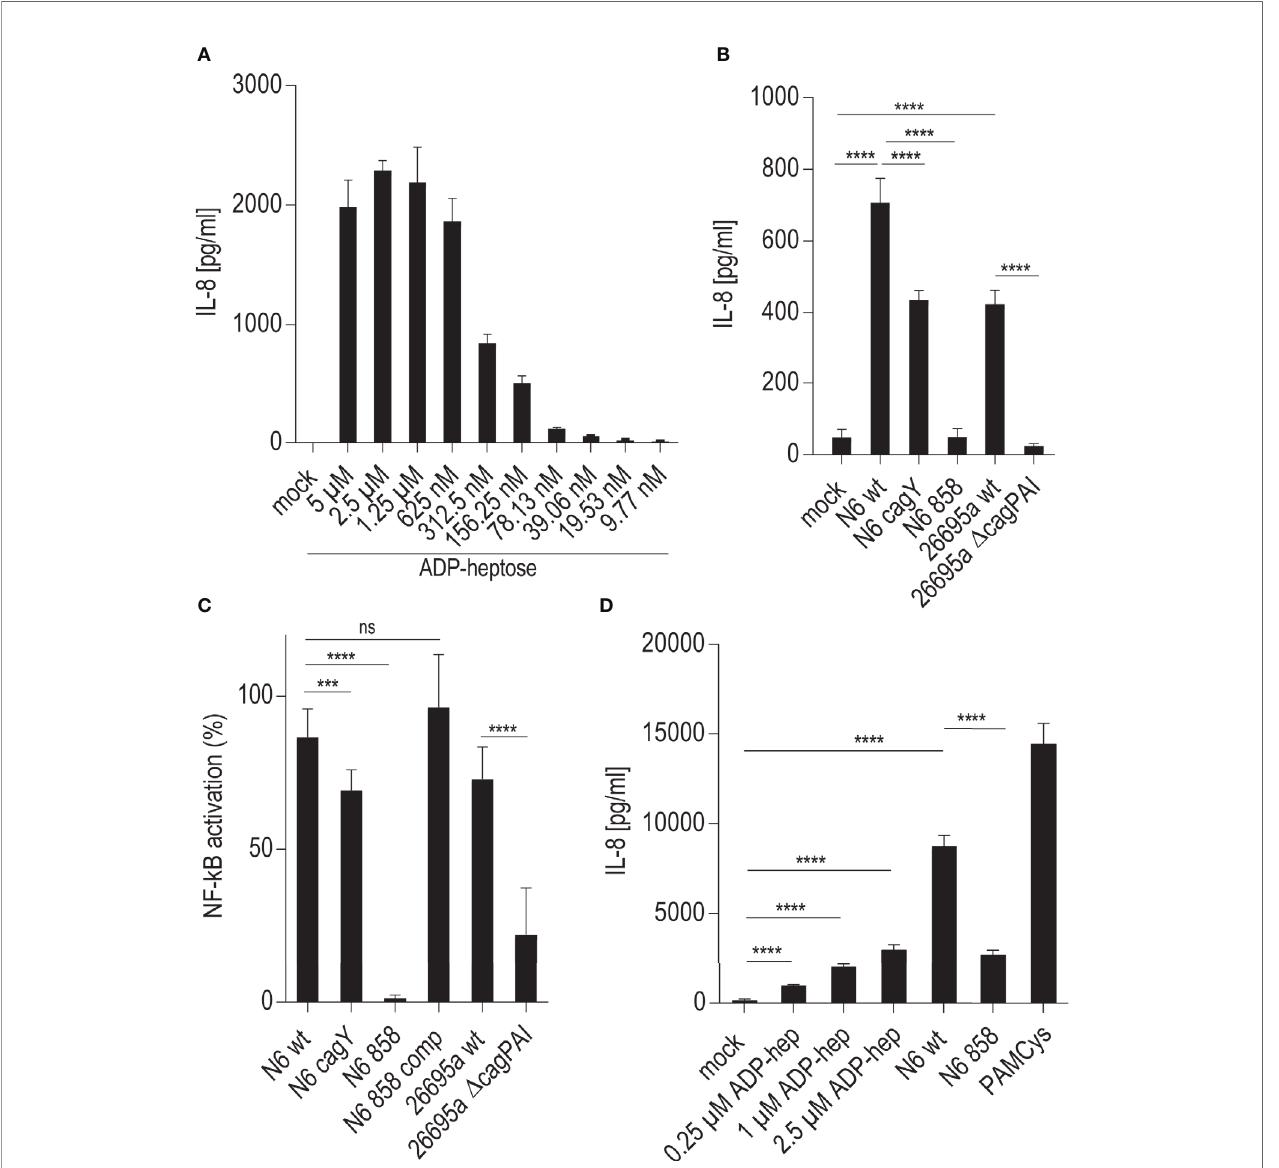
FIGURE 2 | Activation of monocyte/macrophage cell line Thp-1 and primary human macrophages by pure ADP-heptose, enzyme-treated bacterial lysates (ETL), and live H. pylori . (A) dose-dependent activation of Thp-1 cells by pure ADP-heptose: ADP-heptose in different concentrations as indicated was applied to Thp-1 monocyte/macrophages for 20 h in 24-well plates, and IL-8 secretion was quantitated using ELISA (for comparison, concentration-dependent activation of NF- k B reporter cells Thp1_luc by ADP-heptose is shown in Supplementary Figure S3A ). (B) Thp-1 cells were co-incubated with ETLs of two H. pylori strains and their isogenic cagY , D cag PAI, and hldE mutants for 20 h in 24-well plates (50 µl of lysates per well added to cells), followed by the quantitation of IL-8 secreted in the cell supernatant by ELISA. (C) ETLs prepared from two different H. pylori strains including their isogenic heptose mutant (N6 858) and complementant (N6 858 comp), cagY and cag PAI-deletion mutant ETLs were comparatively tested for NF- k B induction in 96-well format (Thp1_luc cells, 4 h co-incubation, 2.5 µl of lysate/well). Relative values in %, normalized to an independent reference (PAMCys) which was set to 100%, are depicted. cagY ETL led only to a mild reduction of NF- k B compared to wt ETL, while cag PAI mutant ETL was associated with a strong reduction of activation. ETLs or pure ADP-heptose alone did not induce signi fi cantly higher IL-1 b secretion than mock-co-incubated cells under the tested conditions, while PAMCys induced IL-1 b (not shown). No pre-activation or priming was used in these assays. One of at least three independent biological experiments is shown in each panel. (D) Primary human monocyte-derived macrophages (hMDMs) were treated with pure ADP-heptose in different concentrations (hep; as indicated), with PAMCys (400 ng/ml) and with live bacteria (MOI 5; N6 wt is H. pylori N6; N6 858 is isogenic H. pylori hldE mutant de fi cient in LPS core heptose biosynthesis) in 24-well plates. Cell activation was quantitated by IL-8 ELISA. Primary macrophages were signi fi cantly activated by ADP-heptose in a concentration-dependent manner. Biosynthesis-de fi cient hldE mutant activated signi fi cantly less than H. pylori wild type bacteria. Mean and standard error of six replicates is shown for each condition. Statistical signi fi cance of differences in (A – D) was calculated using unpaired student ’ s t- test. Signi fi cant p values: ****p < 0.0001; ***p < 0.001; ns is non signi fi